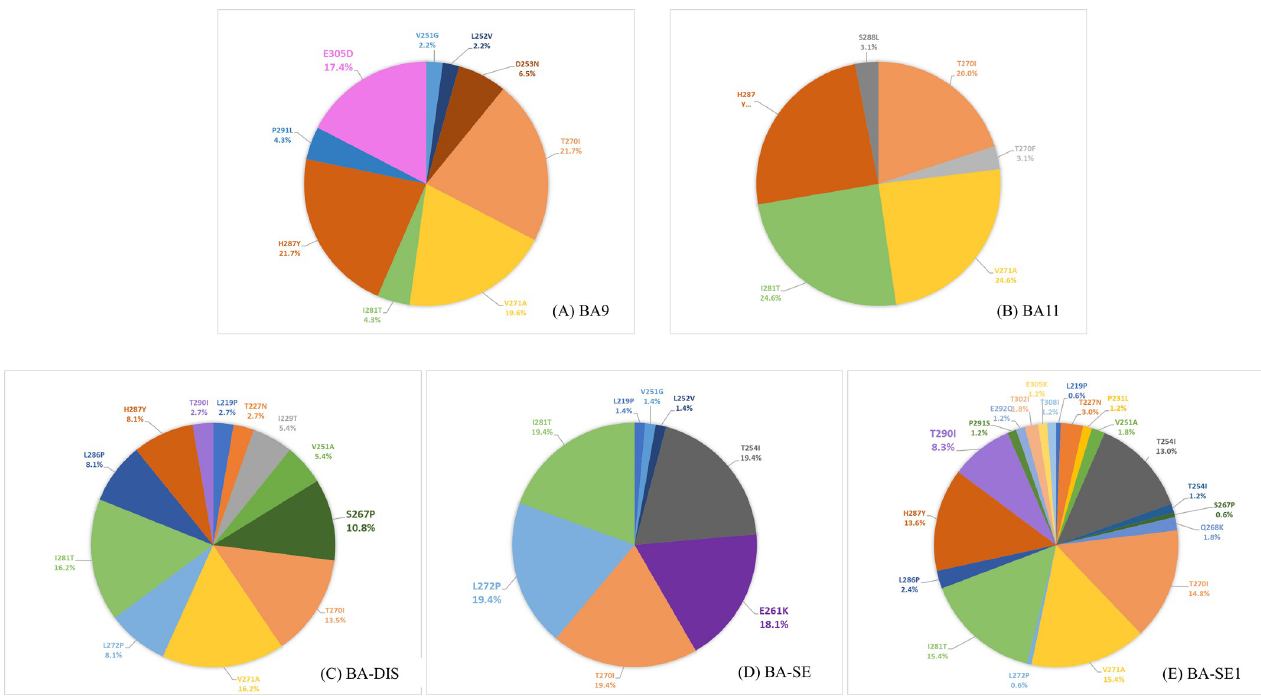
Fig 7. Proportion of amino acid variations in five Seoul RSV-B strains. The variations in amino acid sequences observed within the 2 nd HVR region of G gene of the Seoul RSV-B G gene were visually represented using different colors corresponding to the specific variations present, (A) BA9, (B) BA11, (C) BA-DIS, (D) BA-SE, and (E) BA-SE1. Unique variations that were not present (or hardly present) in other strains were highlighted in bold letters for each strain; (A) E305D in BA9, (C) S267P in BA-DIS, (D) E261K/L272P in BA-SE, and (E) T290I in BA-SE1.